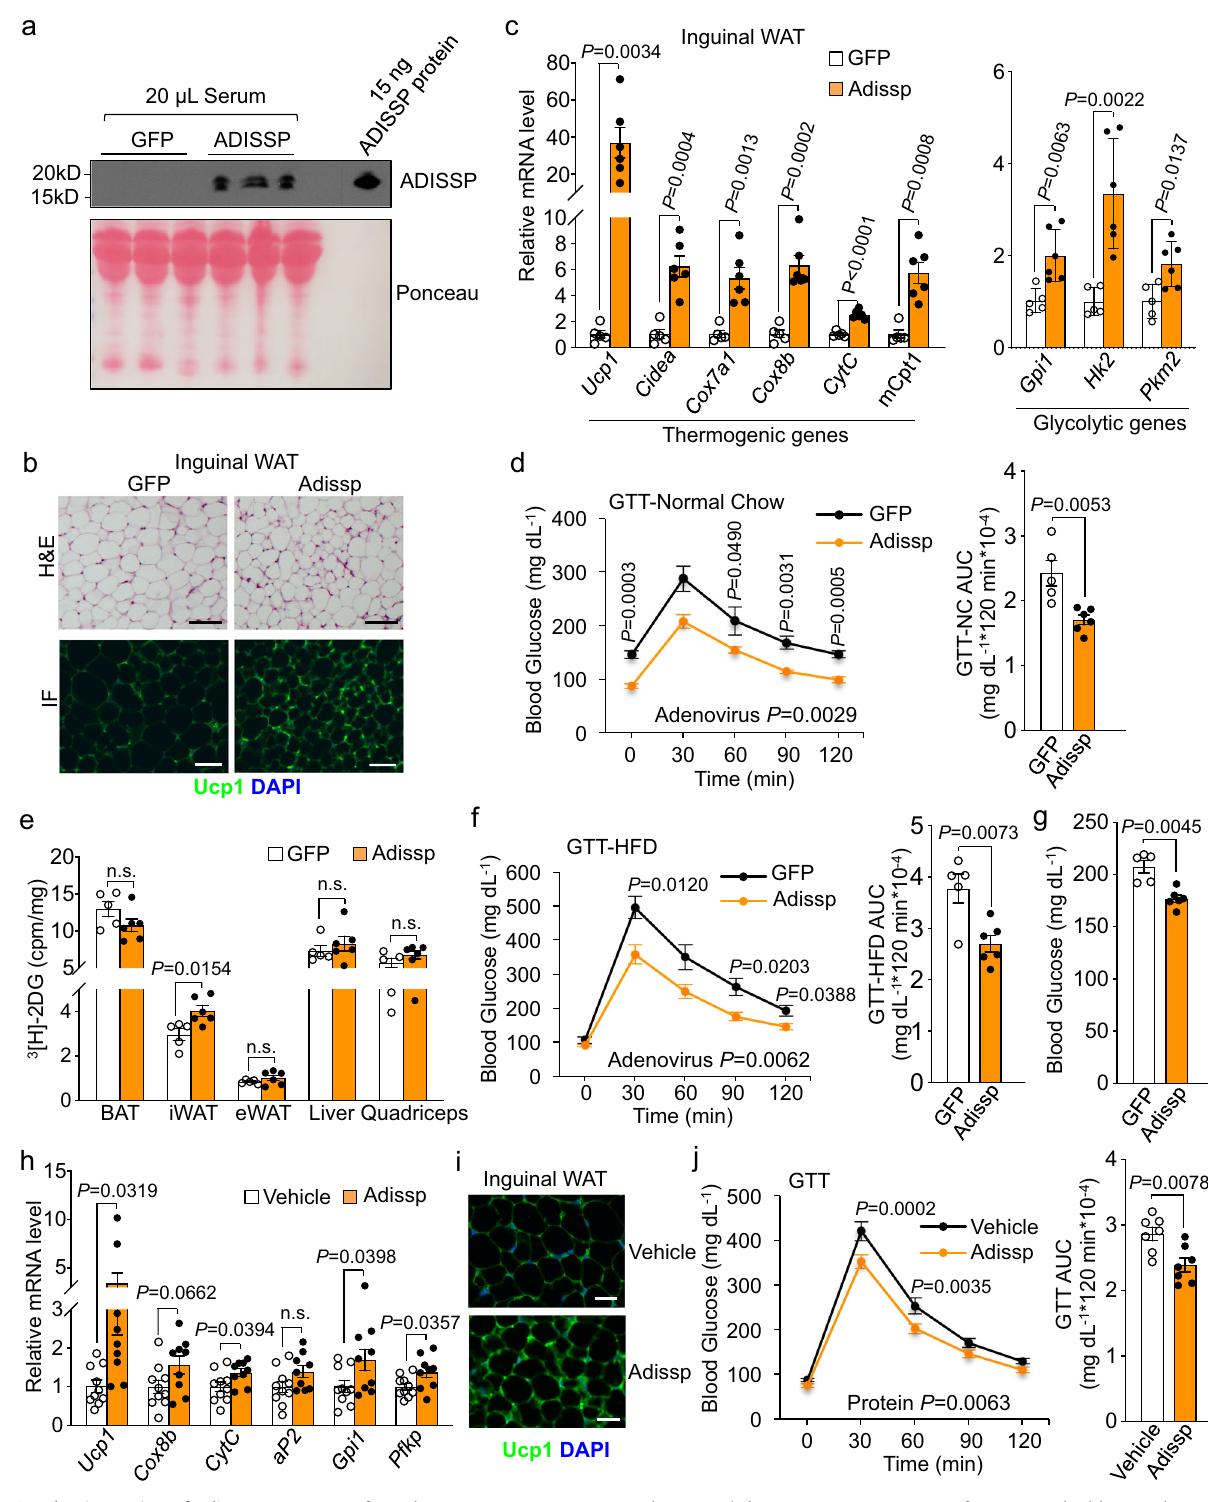
Fig. 4 | Endocrine action of Adissp. a Detection of circulating ADISSP protein ( n =3 mice per group). b Representative images of H&E staining and Ucp1 immu- no fl uorescence staining in iWAT from indicated adenovirus-injected mice ( n =3 micepergroup).Scalebar,200 μ m. c mRNAexpressionofindicatedgenesiniWAT from adenovirus-injected mice (GFP, n =5; Adissp, n =6). d GTT in adenovirus- injected mice fasted for 5h (GFP, n =5; Adissp, n =6). e Quanti fi cation of 3 H-2DG uptakeinindicatedtissuesfromadenovirus-injectedmice(GFP, n =5;Adissp, n =6) after5hfasting. f